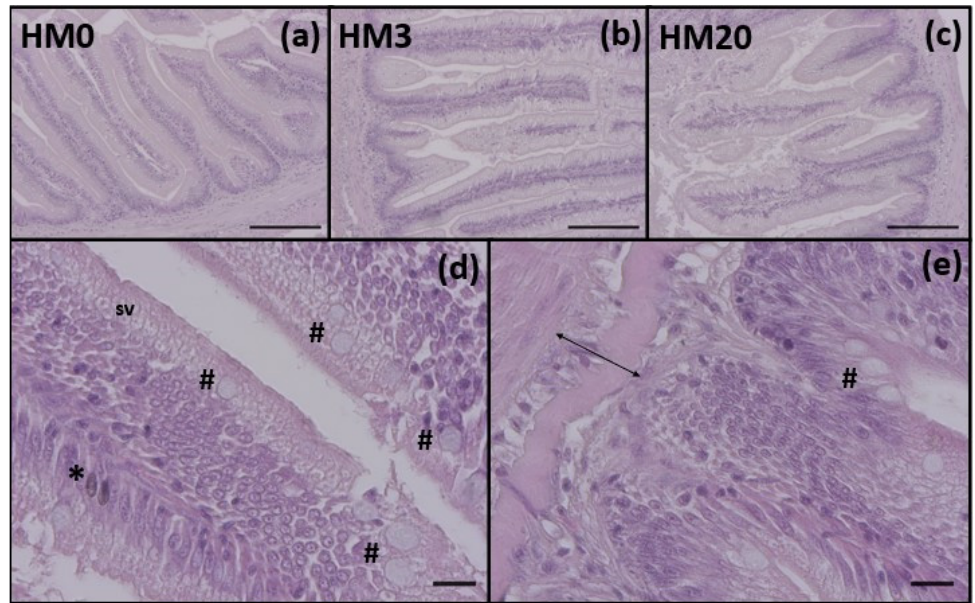
Figure 1. ( a – c ) Example of distal intestine histomorphology of rainbow trout fed experimental diets: ( a ) HM0, ( b ) HM3, and ( c ) HM20. ( d , e ) Details of mucosal folds (asterisk indicates melanomacrophages, hashtag indicate goblet cells, sv indicates supranuclear vacuoles and arrow indicate submucosa width). Scale bars: ( a – c ) = 200 µ m; ( d , e ) = 20 µ m. Table 5. Histological indexes (mucosal fold height, submucosa width, supranuclear vacuoles and goblet cell abundance) measured in distal intestine of rainbow trout fed experimental diets. HM0 HM3 HM20 Mucosal folds height ( μ m) 1165.4 ± 30.3 a Submucosa width ( µ m) Goblet cells Supranuclear vacuoles ++ ++ ++ Scores: supranuclear vacuoles + = scattered, ++ = abundant. Different letters indicate significant dif-